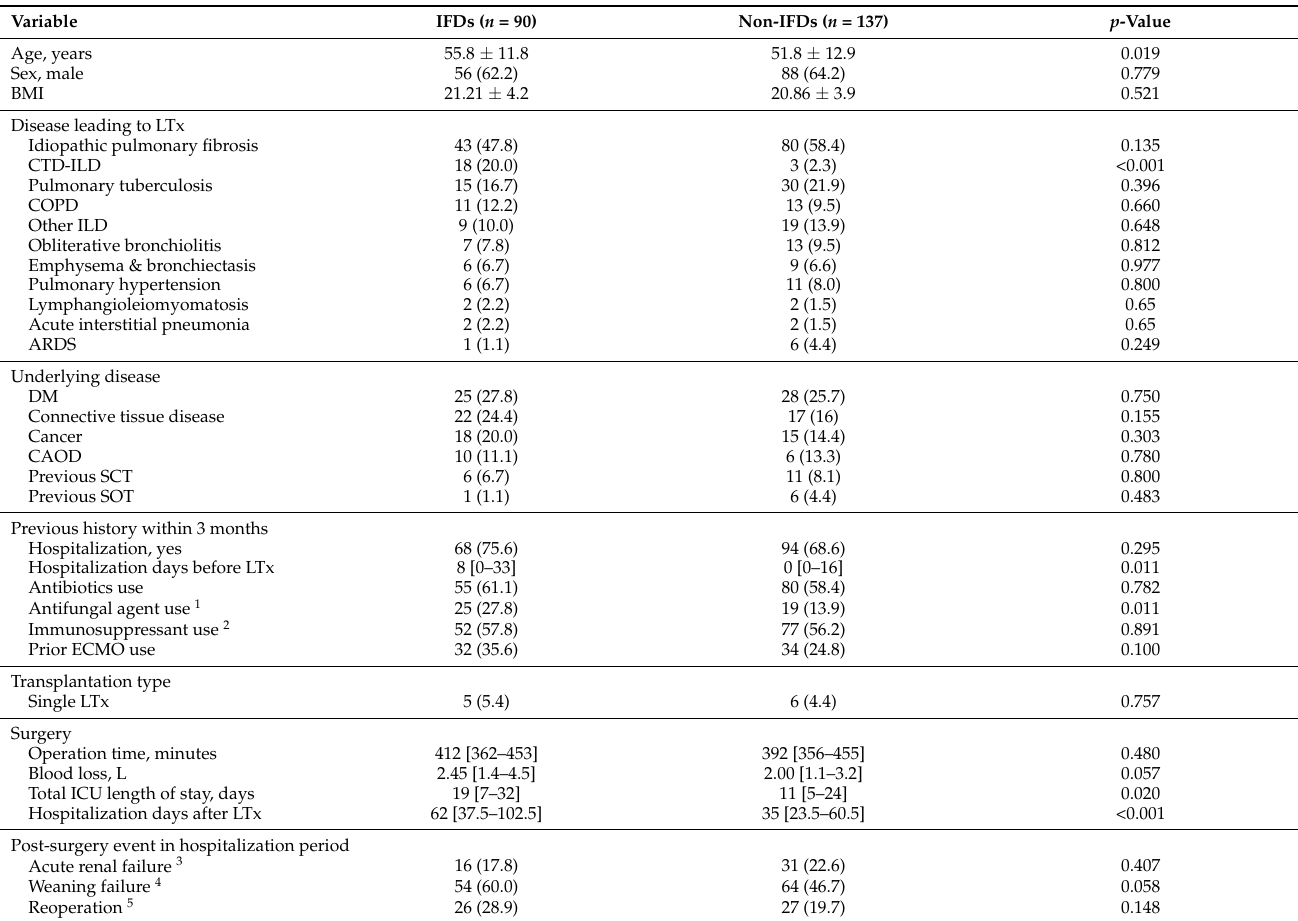
Table 2. Baseline and perioperative characteristics of the study population.